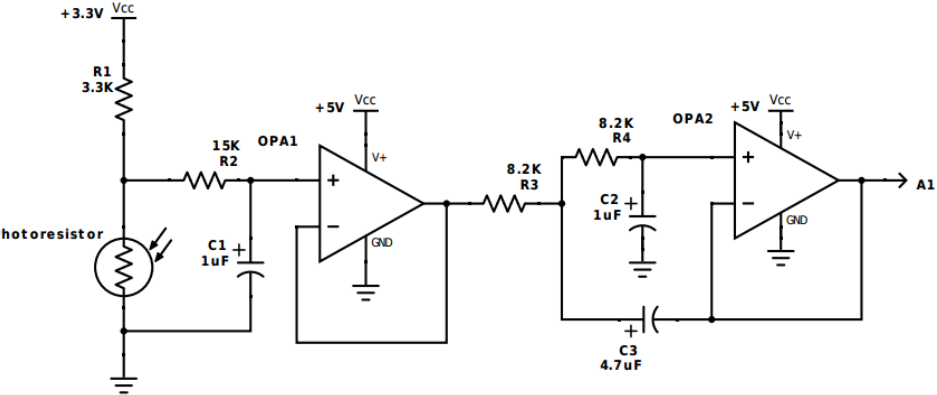
Figure 6. Ambient Light Sensor, where GND is the ground V = 0.